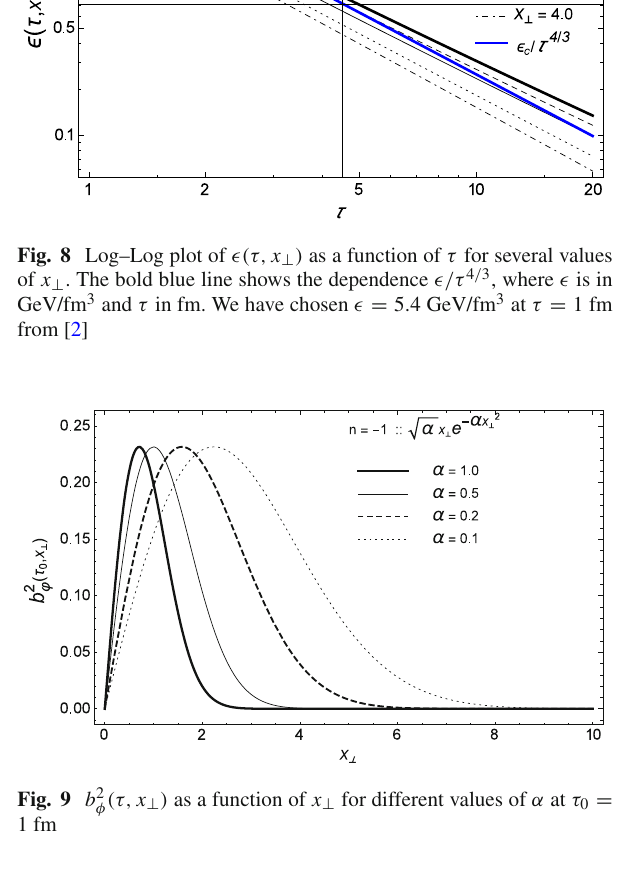
the parameter 1 / q 2 in Ref. [2]: indeed the radial flow veloc- ity (versus x ⊥ at τ = 0 . 6 fm) becomes smaller when 1 / q